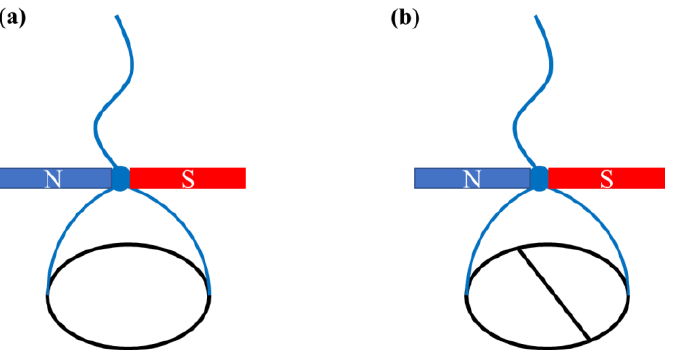
Figure 1. ( a ) Rayleigh’s experiment involving a ring of thin brass wire placed on the surface of the water and dusted over with fine sulfur. The system was magnetically rotated using a magnetized sewing needle (NS). ( b ) A material diameter of the same brass wire was added to the ring. Reprinted with permission from Ref. [17]. Copyright 1890 Copyright Royal Society.